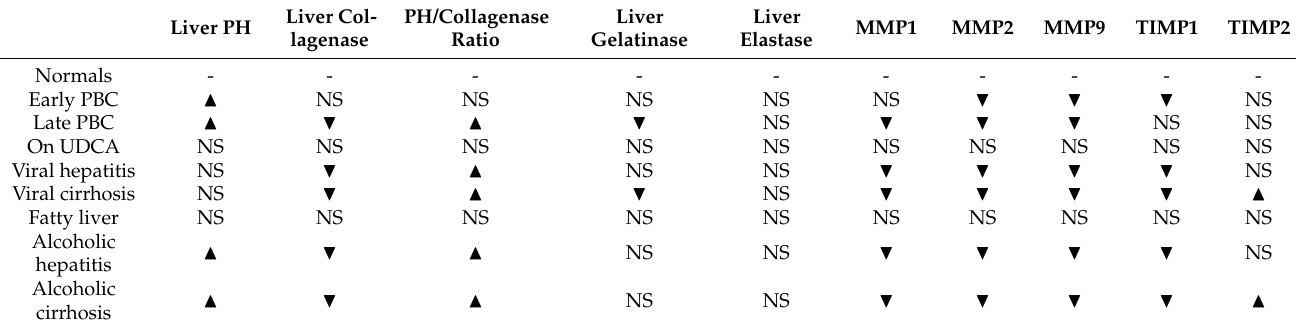
Table 1. Summary of the enzymatic activity by studied